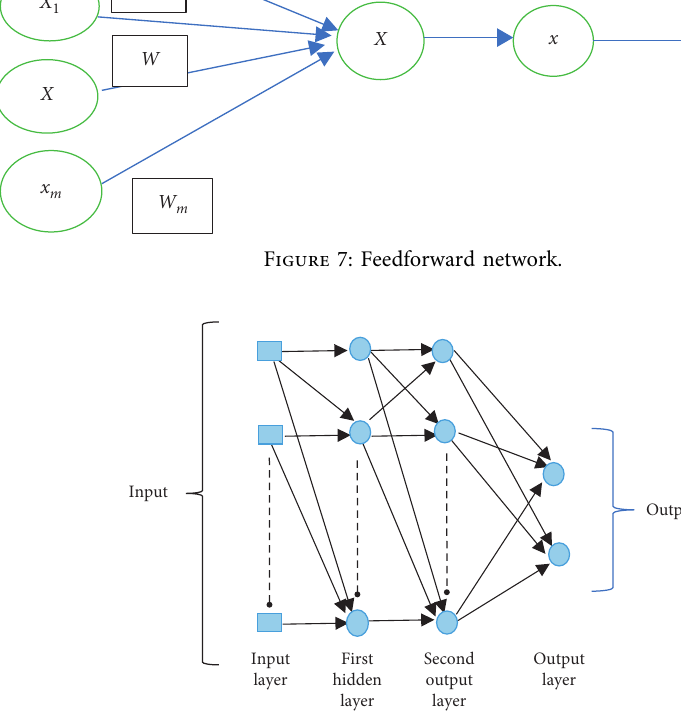
Figure 8: Multilayer perceptron.